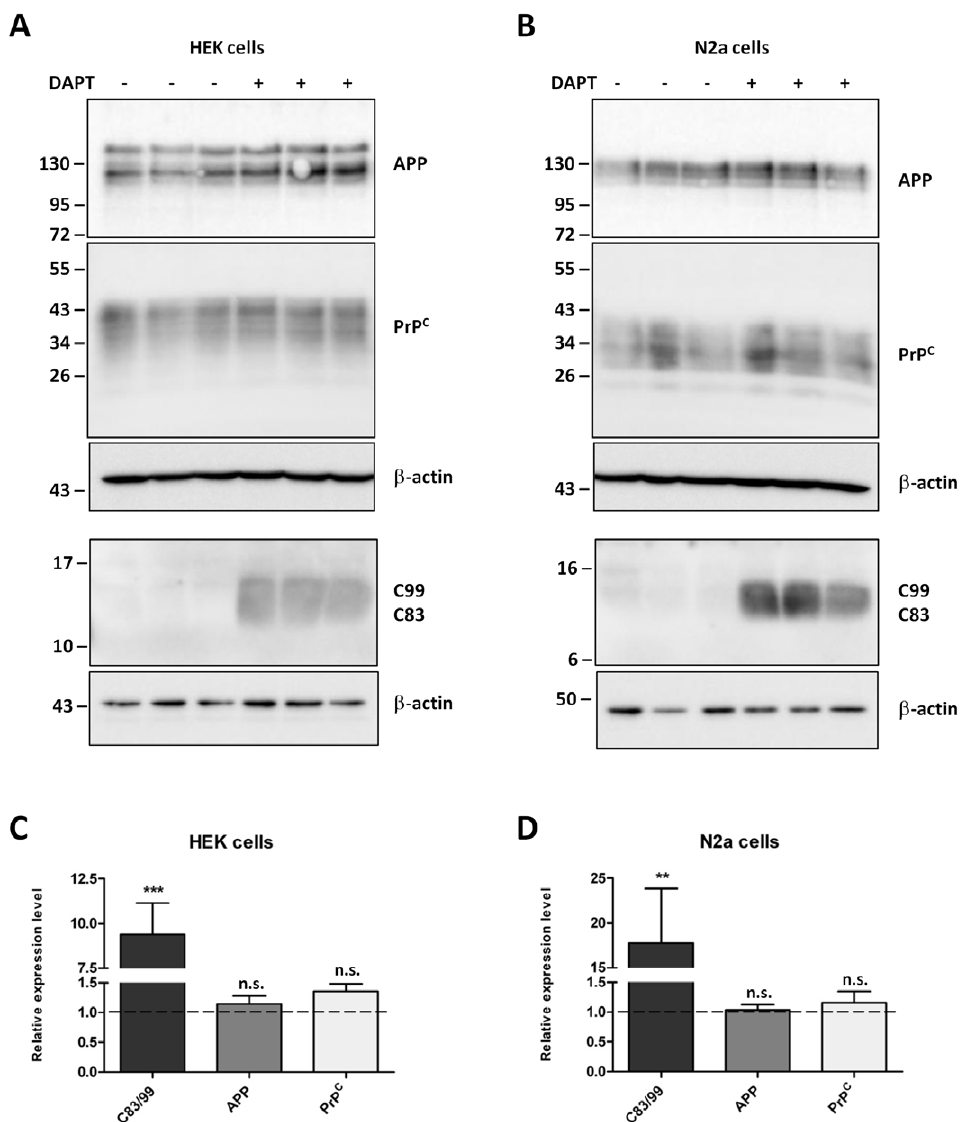
Figure 5. Inhibition of c -secretase activity does not alter the expression of PrP C . Representative western blots showing total cell-associated APP, PrP C (antibody 6H4) and C-terminal APP fragments (C83/99) in control ( 2 ) and DAPT treated ( + ) HEK (A) and N2a (B) cells, with membrane re- probing for b -actin. Approximate molecular weights (kDa) are indicated. Quantification of C83/99, APP and PrP C protein levels in DAPT treated HEK (C) and N2a (D) cells, expressed relative to control cells (dashed line). Data from 3 (HEK) or 4 (N2a) independent experiments. Statistical analysis by one way ANOVA with Dunnett’s post test comparison to the control cells, ***p , 0.001, **p , 0.01, n.s. not significant.